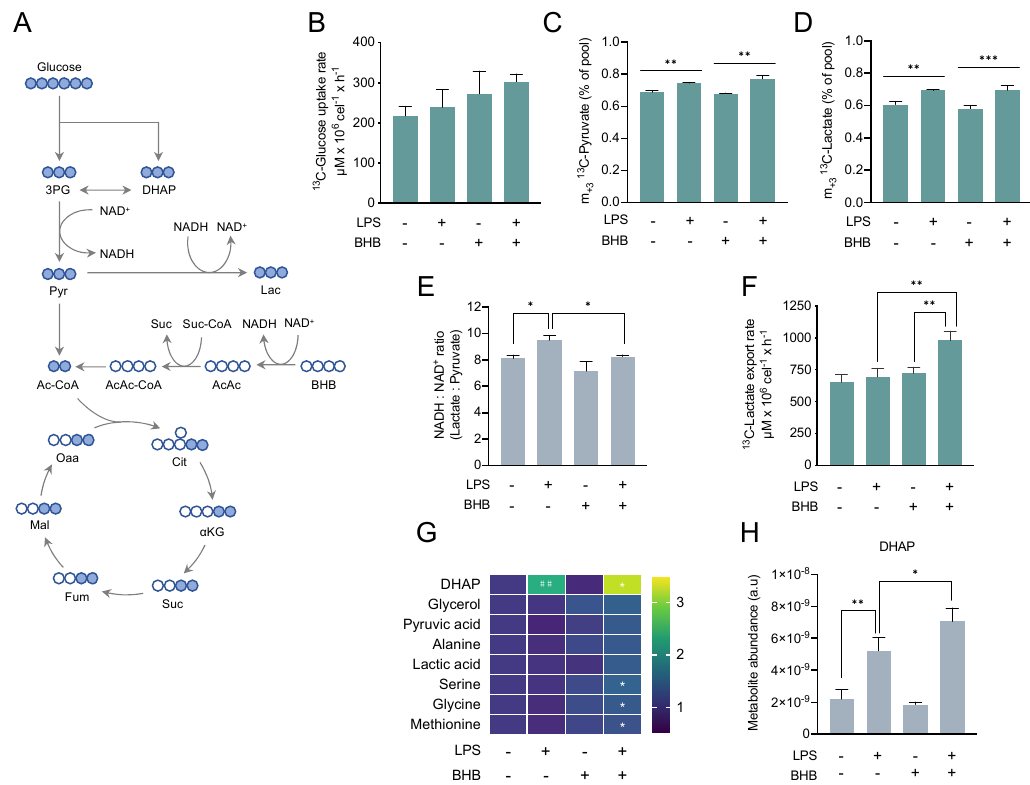
Figure 2. Glycolytic metabolism in response to lipopolysaccharide (LPS) and β -hydroxybutyrate (BHB) in BV2 cells. ( A ) Schematic representation of 13 C enrichment derived from 13 C 6 -glucose. In ( B – H ), cells were seeded and the next day treated with 5 mM 12 C 4 -BHB for 24 h before the media was replaced by fresh media containing 5 mM 13 C 6 -glucose and immediately treated with either 100 ng / mL of LPS, 5 mM of 12 C 4 -BHB or both for 6 h. ( B ) 13 C-glucose uptake rate in cells treated with 100 ng / mL LPS and / or 5 mM BHB for 6 h estimated by 1 H-NMR. Two-way ANOVA (LPS n.s., BHB p = 0.027, LPS × BHB n.s.) followed by Tukey’s test (no statistical significance reached). ( C ) m + 3 13 C enrichment in intracellular pyruvate. Data were analysed by two-way ANOVA (LPS p < 0.0001, BHB n.s., LPS × BHB p = 0.023) followed by Tukey’s test. ( D ) m + 3 13 C enrichment in intracellular lactate. Data were analysed